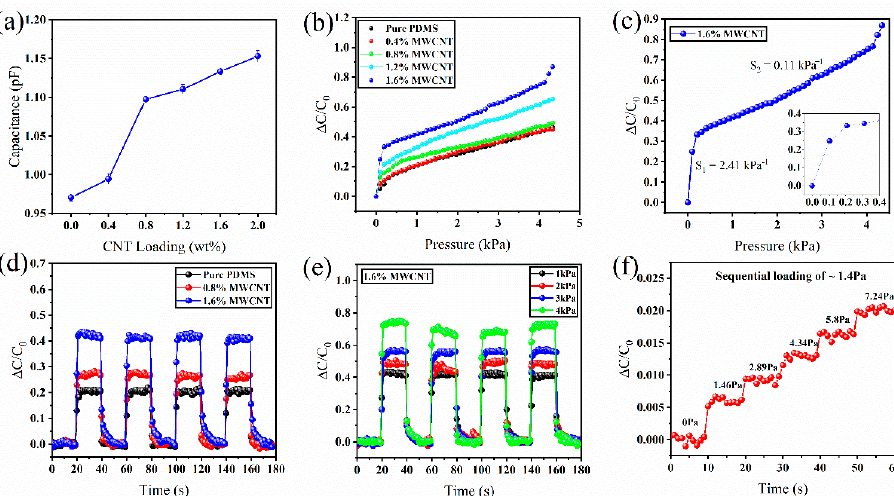
Figure 4. Electromechanical characterization of the MWCNT − PDMS − based pressure sensor. ( a ) Dependence of the initial capacitance based on the concentration of the MWCNTs. ( b ) The relative capacitance change ( ∆ C / C 0 ) vs. pressure for the MWCNT − PDMS − based sensor with varying concentrations of MWCNT in wt.%. ( c ) The plot shows the relative capacitance change ( ∆ C / C 0 ) vs. pressure for the MWCNT − PDMS sensor with 1.6 wt.% of MWCNTs. The inset shows the pressure sensitivity at the low − pressure range. ( d ) Loading-unloading profiles for the MWCNT − PDMS − based sensor with varying concentrations of MWCNTs under 1 kPa pressure. ( e ) Loading-unloading profiles for MWCNT − PDMS − based sensor with 1.6 wt.% MWCNT concen- tration under different pressures. ( f ) Sequential loading of ~1.40 Pa pressure on the pressure sensor showing a minimum detection limit of 1.46 Pa.